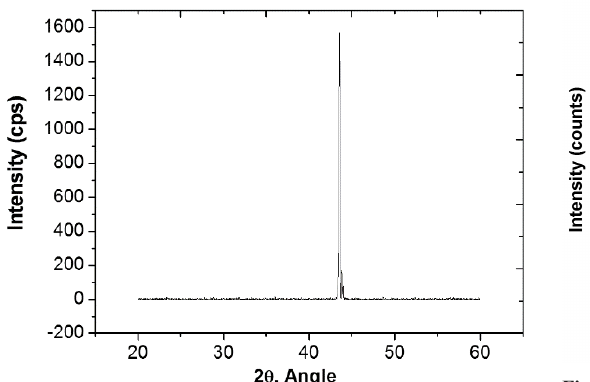
Figure 5. Raman spectroscopy of uncoated diamond, after hot pressing and chemical etching.